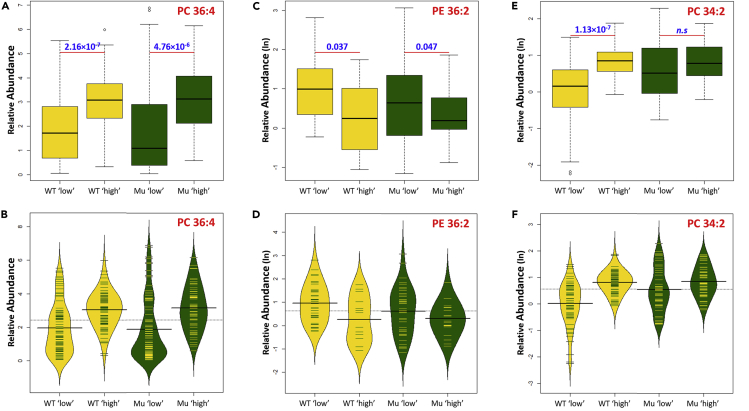
Boxplots and Beanplots Showing Lipid Abundances in Wild-Type and A53T Mutant Neurons after Stratifying Samples by Their Abundance of PC 36:2(A) Boxplot showing the abundance of PC 36:4 in cells with high and low levels of PC 36:2; p values calculated using generalized linear model.(B) Beanplot showing the relative distribution of the abundance of PC 36:4 in cells with high and low levels of PC 36:2.(C) Boxplot showing the abundance of PE 36:2 in cells with high and low levels of PC 36:2; p values calculated using generalized linear model.(D) Beanplot showing the relative distribution of the abundance of PE 36:2 in cells with high and low levels of PC 36:2.(E) Boxplot showing the abundance of PC 34:2 in cells with high and low levels of PC 36:2; p values calculated using generalized linear model.(F) Beanplot showing the relative distribution of the abundance of PC 34:2 in cells with high and low levels of PC 36.PC, glycerophosphocholine; Mu, SNCA-A53T mutant dopaminergic neurons.